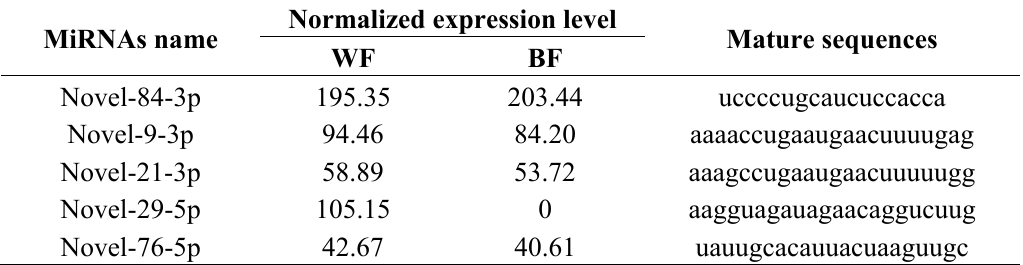
Table 2. The five most abundantly expressed novel miRNAs in goat hair follicels.